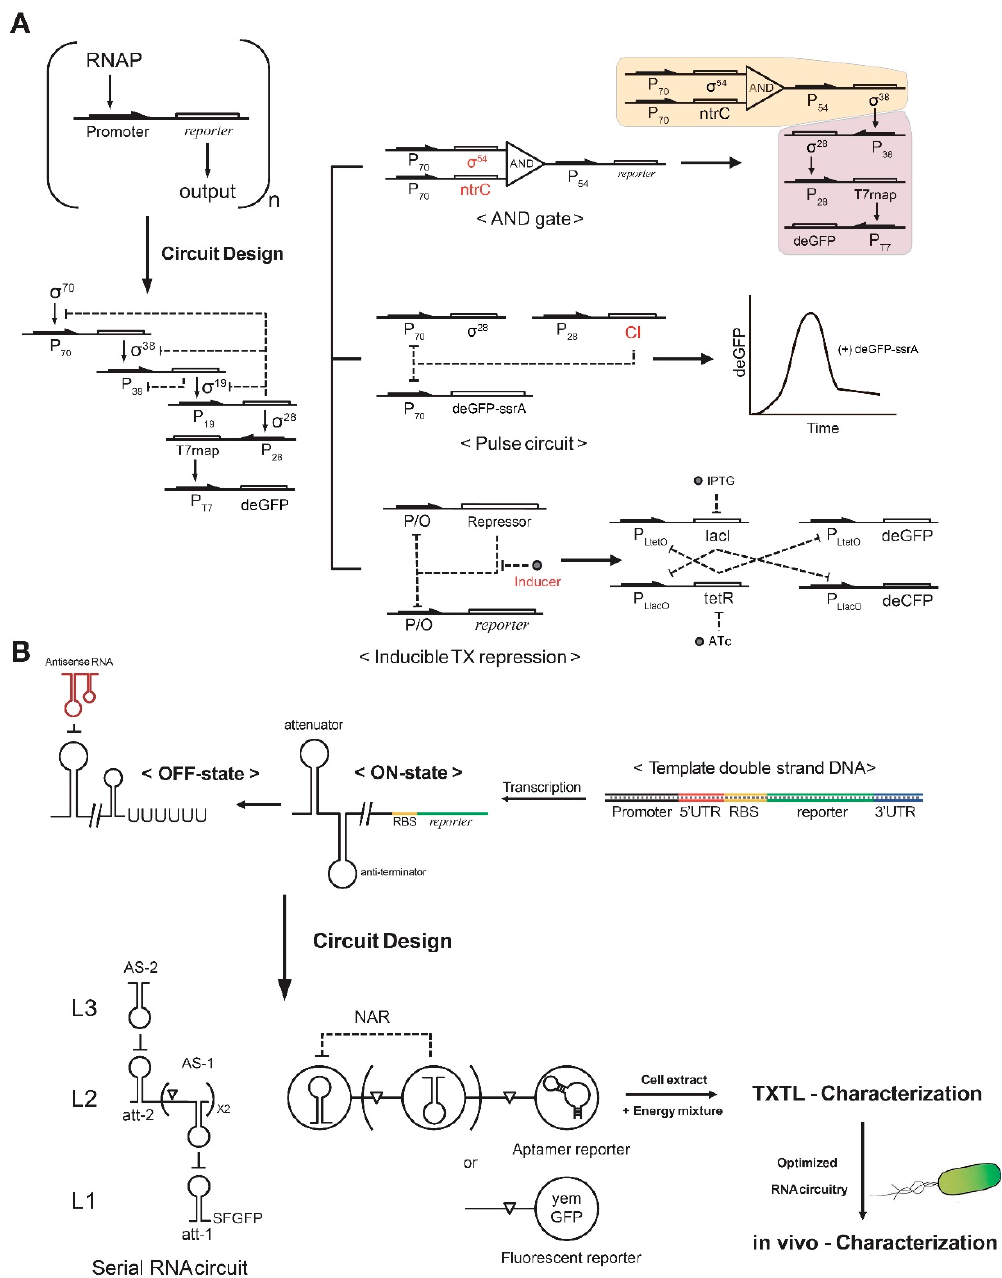
Figure 2. Systematic construction of DNA and RNA circuitry in TXTL. ( A ) Basic (input–parameter– output) modules are integrated to build complex synthetic circuits. Assembly of an AND